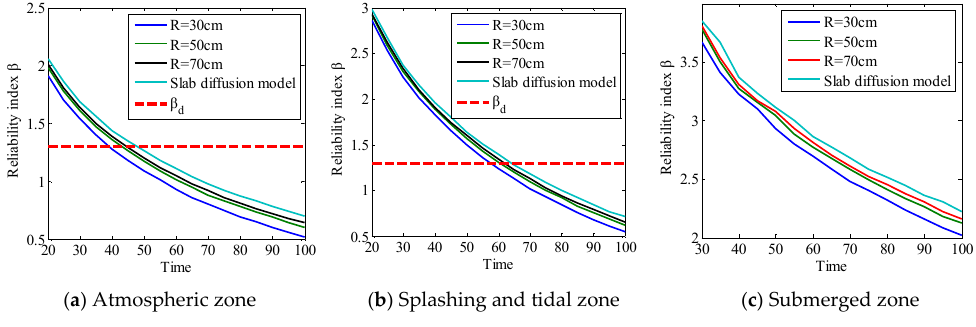
Figure 12. The effect of the shape of circular section on the service life prediction. Figure 12. The e ff ect of the shape of circular section on the service life prediction. Table 5. Service life for di ff erent radius of circular Table 5. Service life for different radius of circular section.